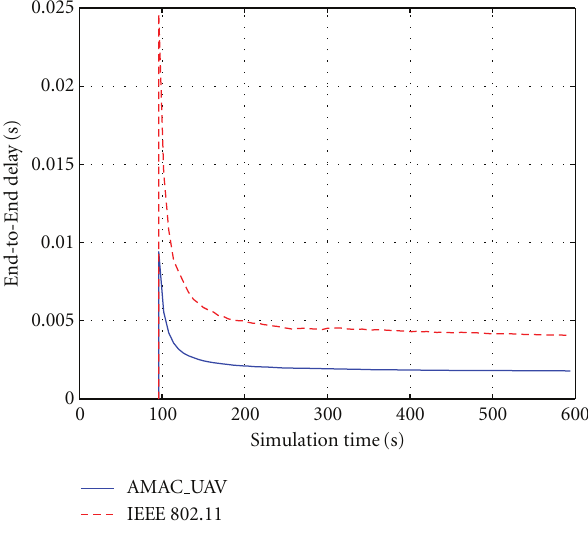
Figure 13: End-to-end delay of a MANET of 25 UAVs. the antenna beam toward the target. The OPNET